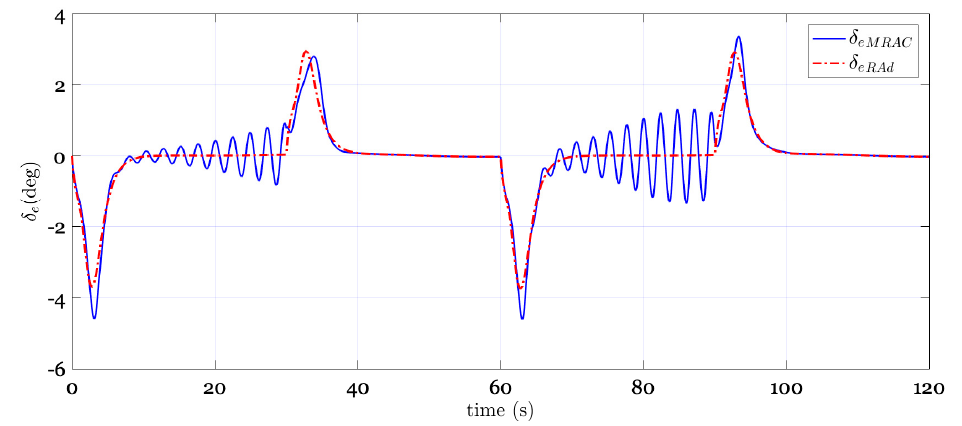
Figure 4. Control signal from MRAC and robust adaptive controller with ρ λ = ρ θ = 0.01.